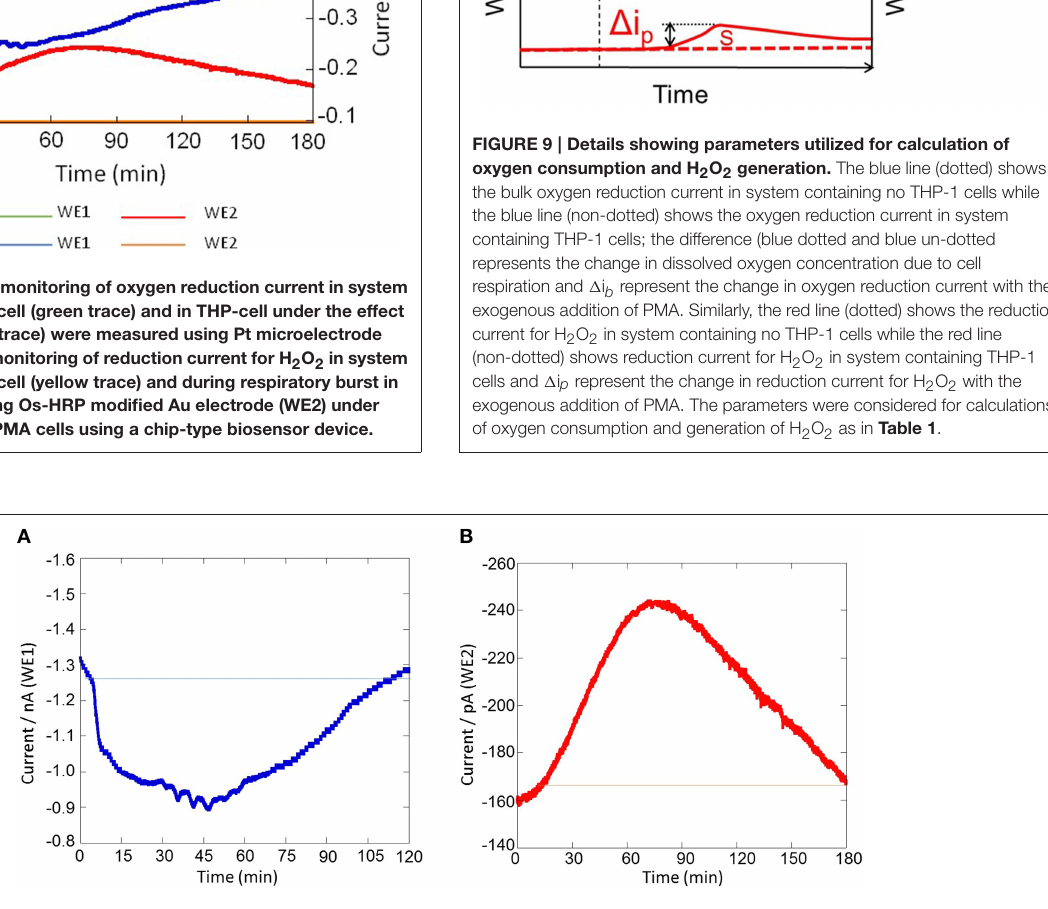
FIGURE 8 | Real-time monitoring of oxygen reduction current and reduction current for H 2 O 2 during respiratory burst in THP-1 under the effect of 200 nM PMA cells using a chip-type biosensor device. Changes in oxygen reduction current was measured using WE1 (A) while changes in reduction current for H 2 O 2 was measured using WE2 (B)